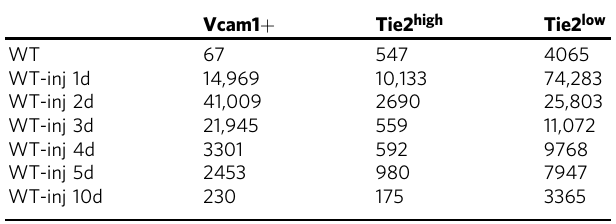
Table 1 Time course analysis: number of cells per subFAPs during muscle regeneration (related Fig.